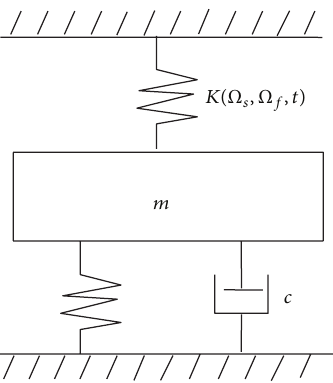
Figure 1: Dynamic model of pantograph-catenary